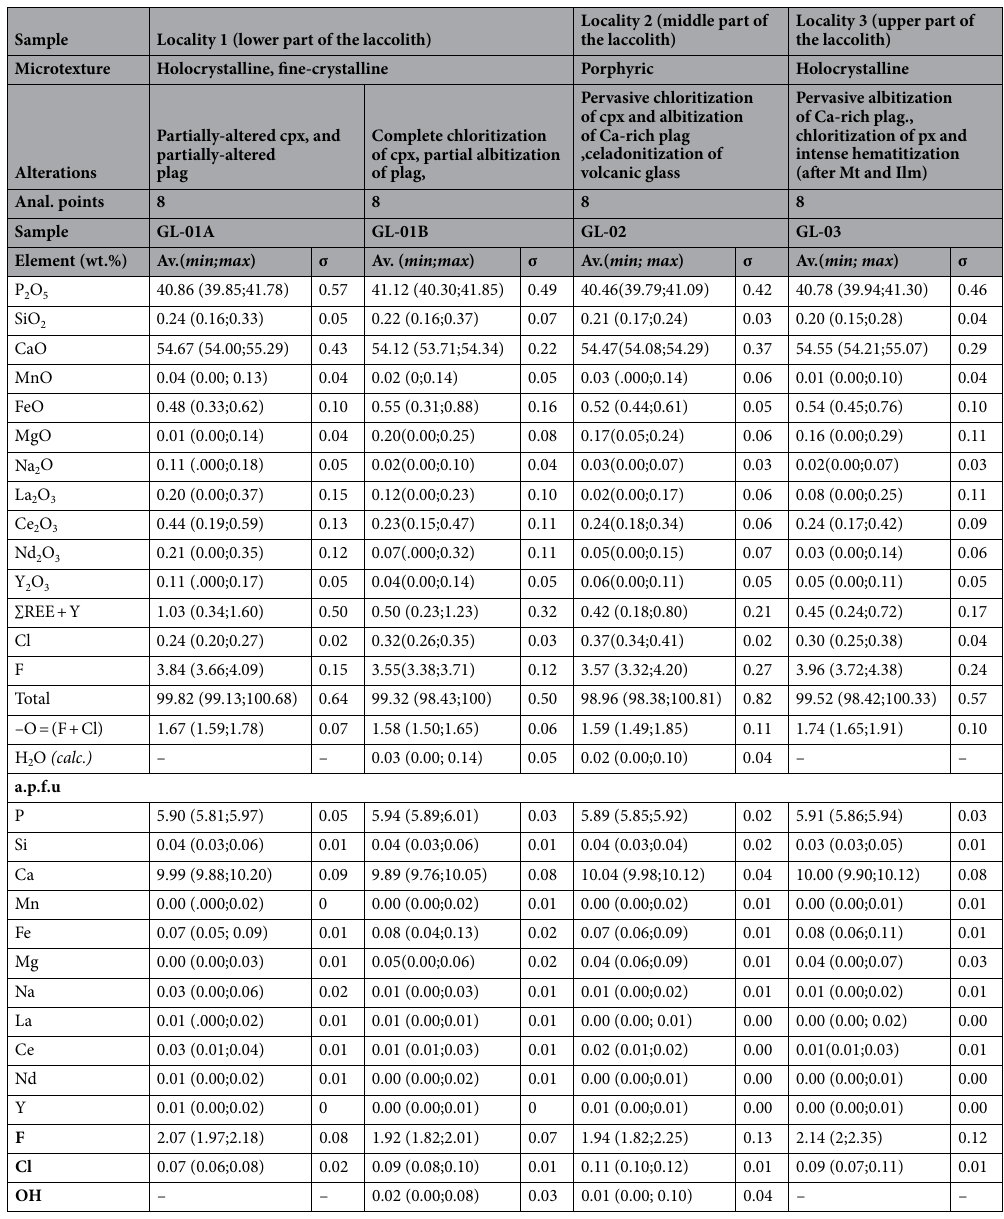
Table 5. Position and assignment of Raman bands for co-existing augite and aegirine. Note: Cpx— clinopyroxene (augite and aegirine); plag—primary plagioclase